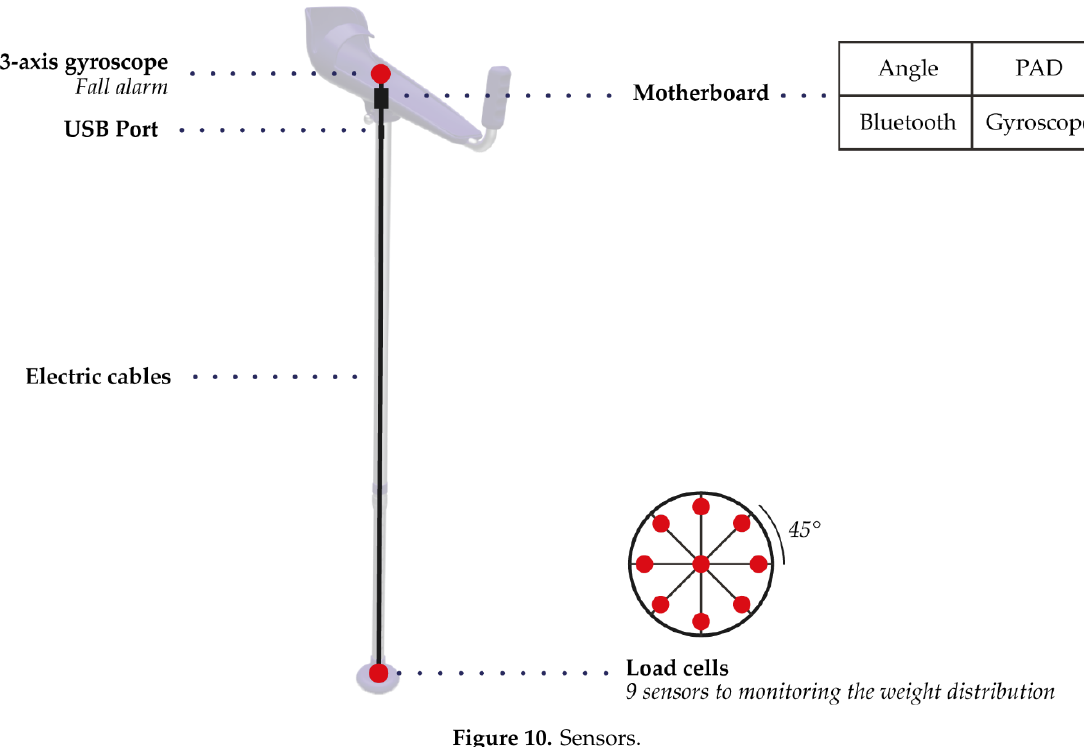
Figure 10. Figure 10. Sensors.